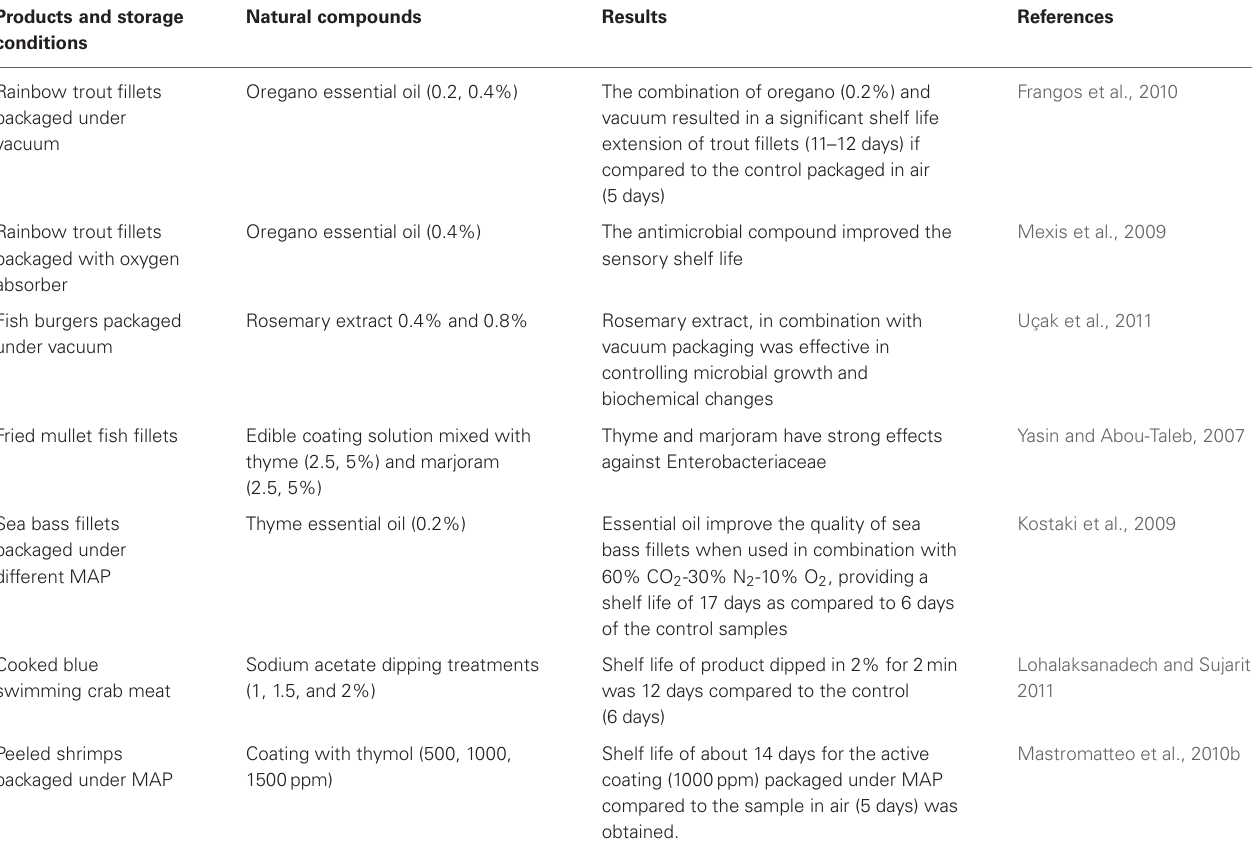
Table 4 | Relevant examples of natural active agents applied to fish-based